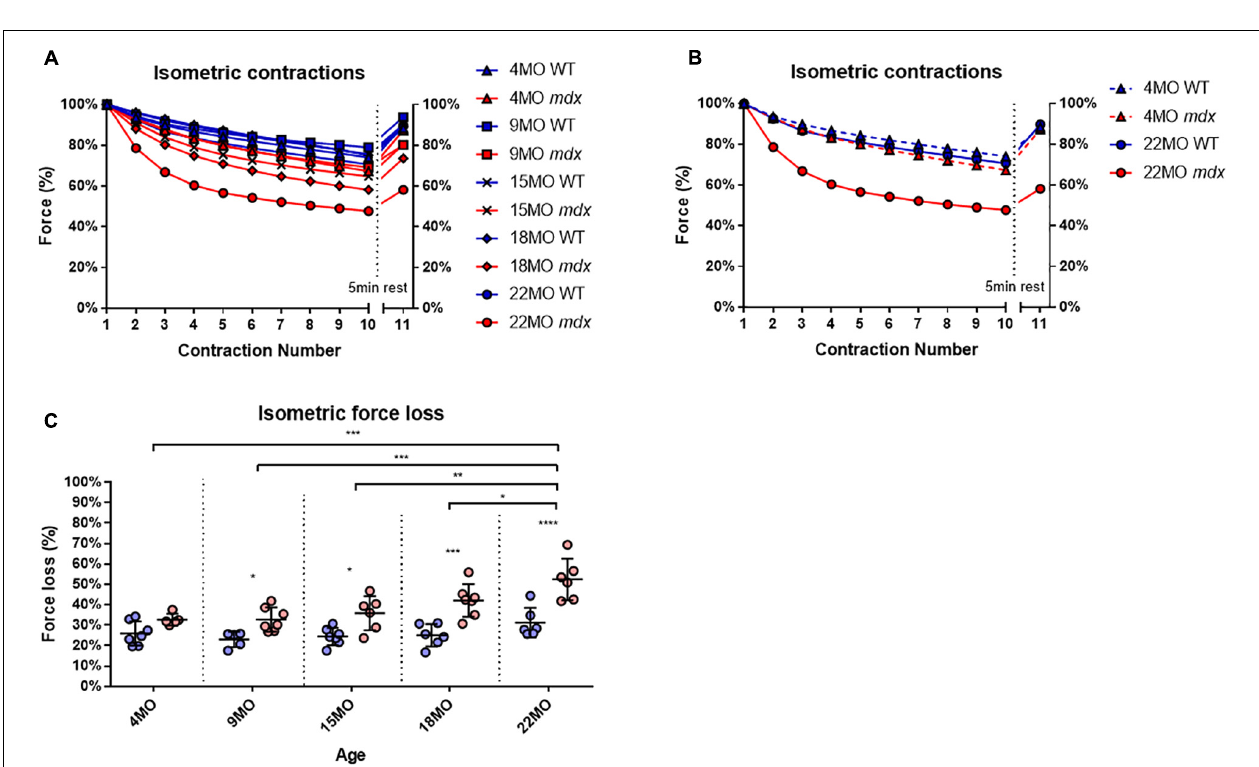
FIGURE 5 | Percentage force changes throughout repeat isometric contractions and recovery. (A) Shows the change in isometric force expressed as a percentage of starting force across 10 consecutive contractions and an 11th recovery contraction after 5 min for all age groups. (B) For clarity, 4-month and 22-month old age groups have been isolated to highlight the differences in isometric force loss and recovery across these contractions. Data shown in these curves are mean only; SD was omitted for visual clarity. (C) An interleaved scatterplot of the cumulative force loss by the EDL across 4-month ( n = 7 control; n = 5 mdx ), 9-month ( n = 5 control; n = 7 mdx ), 15-month ( n = 7 control; n = 6 mdx ), 18-month ( n = 6 control; n = 7 mdx ), and 22-month ( n = 6 control; n = 6 mdx ) age groups (Note: these numbers apply to A–C ). In each interleaved scatterplot group the horizontal line indicates the mean value ± SD. Statistical differences between age groups are displayed above the graph, statistical differences displayed within graphs are differences between genotypes assessed by two-way ANOVA, post hoc analysis using Sidak’s multiple comparisons test. **** P < 0.0001, ***0.0001 < P < 0.001, **0.001 < P < 0.01, and *0.01 < P <